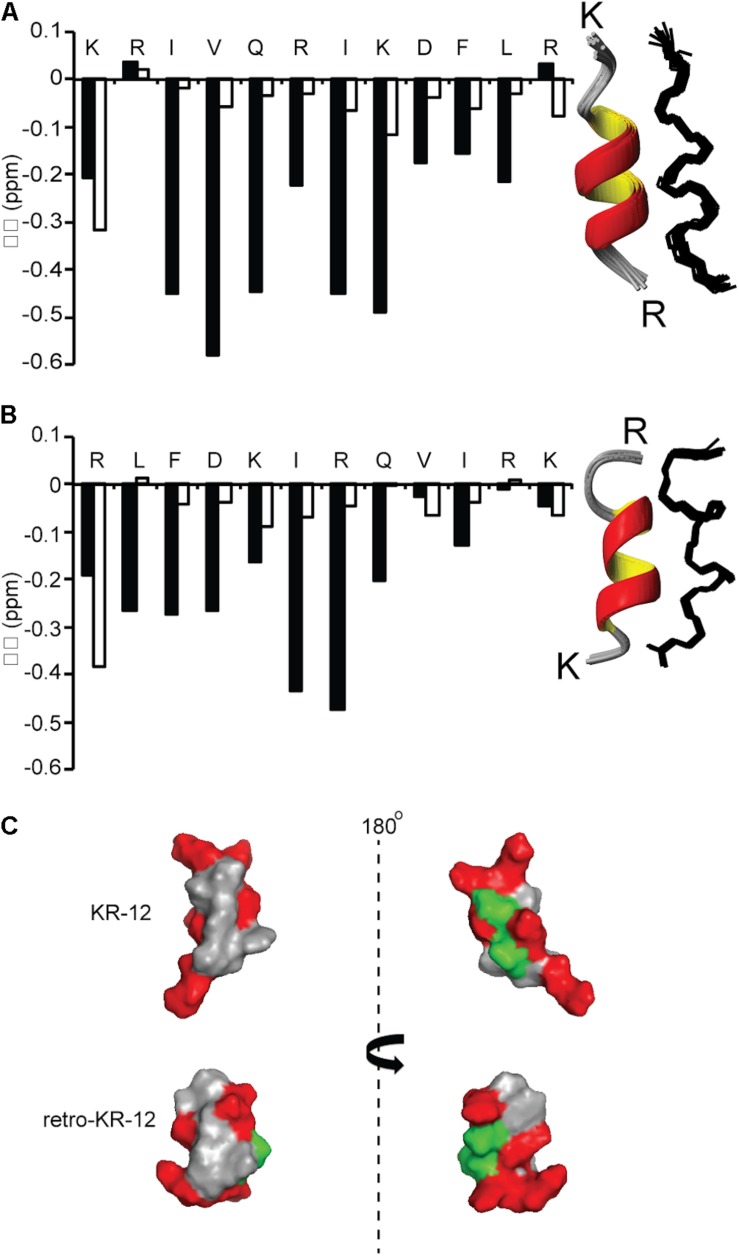
Comparison of secondary and three dimensional structures of KR-12 and retro KR-12. Secondary chemical shift (Δδ) was calculated by subtracting random coil αH chemical shift from the experimental αH chemical shift. Stretches of negative values (<0.1) represent alpha-helical structure. (A) KR-12 (B) retro-KR12; white bars represent the peptide in H2O:D2O (90:10 v/v) and black bars represents the peptide H2O:D2O (90:10 v/v) together with deuterized SDS (1:40, peptide:SDS). The corresponding three dimensional structures are represented by superimposition of the 15 lowest-energy structures (Ribbon and Line structures). (C) Ribbon structure with the lowest energy and surface representation of the structure; hydrophobic residues are highlighted in gray, polar residues in green and positively charged in red. The left view has similar orientation as the ribbon model and the right view is from the back. In the current paper, the KR-12 structure was calculated with higher number of distant constrains, i.e., 245 distant constrains (81 sequential restrains, 54 medium range restrains, 16 H bond restrains) in comparison to 86 distant restrains (37 sequential, 32 medium range, no H bonds) used in a previous study. The RMS deviation from mean coordinate structure for backbone atoms is similar for KR-12 in SDS (0.2 ± 0.05) and KR-12 in D8PG (0.24). Stereochemical quality of the KR-12 structure in SDS is 94 ± 6.11% residues in the most favored Ramachandran region in contrary to 90% residues reported for KR-12 in D8PG (Wang, 2008).